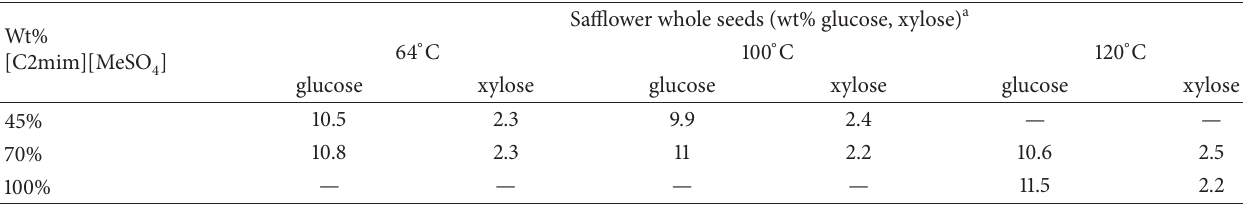
Table 3: Weight percent fermentable sugars (relative to weight of whole seed) released from safflower whole seed pretreated with the co- ]-MeOH. solvent [C2mim][MeSO 4